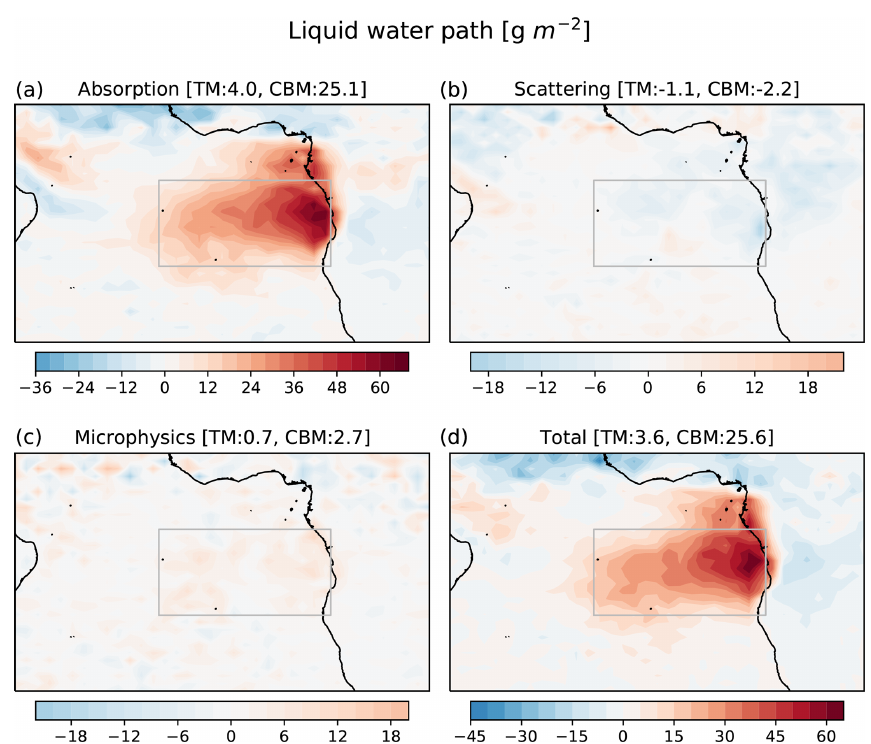
Figure 7. UKESM1-simulated mean spatial distribution of the BBA effects of (a) absorption, (b) scattering, (c) microphysical, and (d) total on the cloud liquid water path during July and August 2016–2017. The domain range is from 30 ◦ S to 10 ◦ N and from 40 ◦ W to 30 ◦ E. The TM is the total mean of the domain and the CBM is the mean of the cloud box (the grey box on the map) representing the areas where the average low cloud fraction is above 0.58. The same colour scale is used in each plot to facilitate comparison, but the colour map ranges differ in each plot, corresponding to the maximum and minimum variation of LWP in